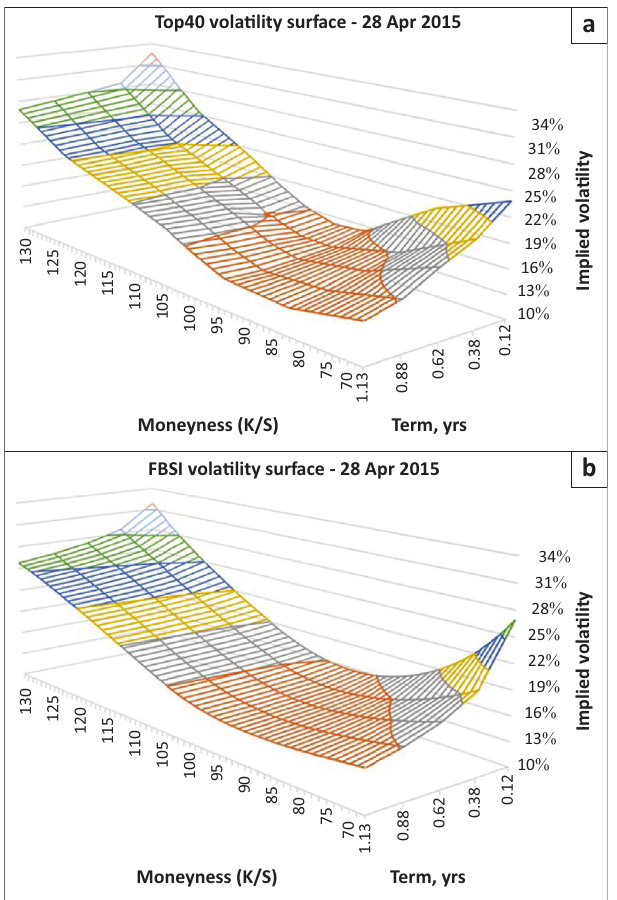
FIGURE 8: (a) Top40 and calibrated and (b) FBSI implied volatility surface as at 30 May 2011.